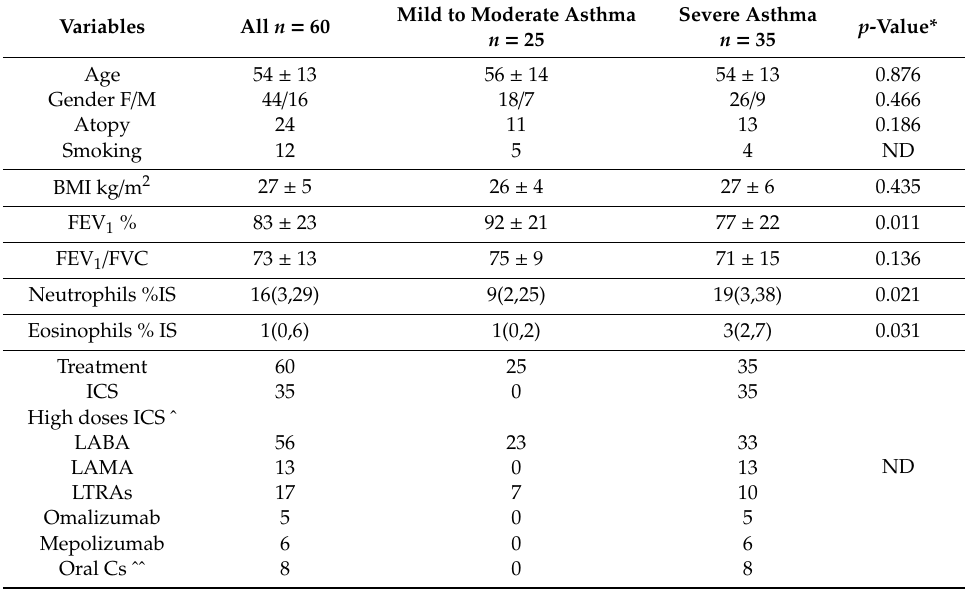
Table 1. Subjects